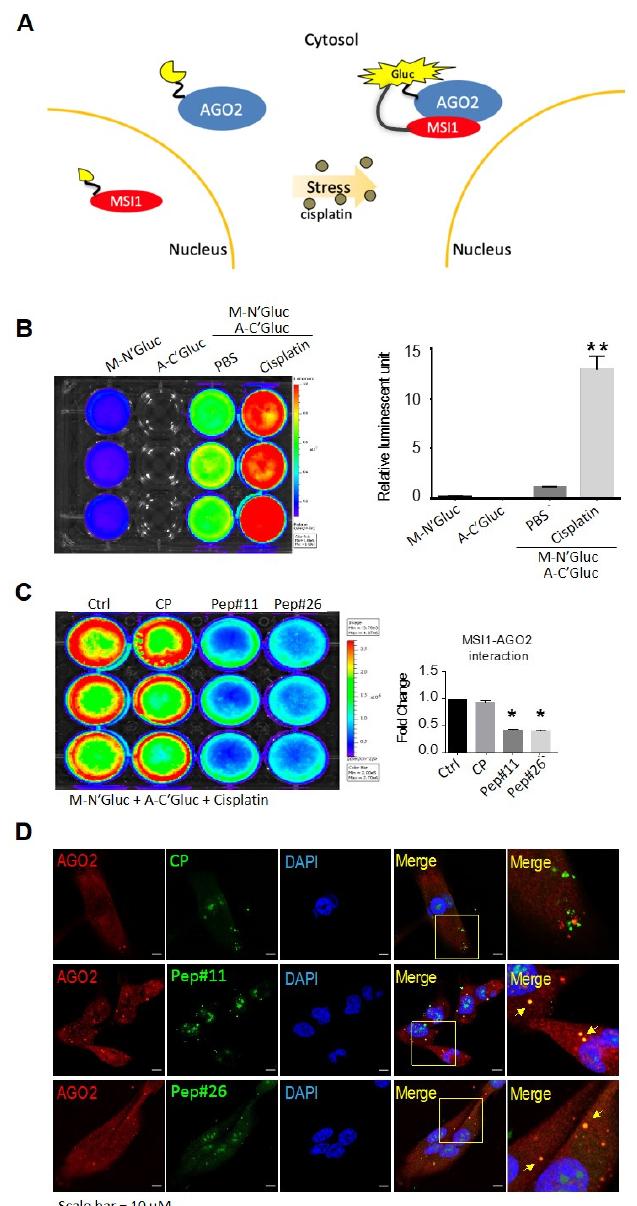
Figure 4. MSI1 C-terminal peptides Pep#11 and Pep#26 acted as decoys for MSI1/AGO2 interaction under cellular stress. ( A ) A schematic illustration that shows in vitro Gaussia luciferase reconsti- tution assay for the detection of MSI1 and AGO2 protein–protein interaction. ( B ) Gluc-mediated MSI1/AGO2 interaction was quantitatively determined using the split luciferase reconstitution assay as monitored by IVIS imaging system. In total, 30 µ M of cisplatin was used to induce cellular stress that led to MSI1/AGO2 interaction. M-N’Gluc (MSI1-N-terminal-Gluc); A-C’Gluc (AGO2-C-terminal- Gluc). **, p < 0.01. ( C ) Under the same cellular stress conditions induced by cisplatin, tat-conjugated CP (control peptide), Pep#11, and Pep#26 were employed, and luciferase signals were detected and quantitated by comparison to no treatment control (Ctrl) as normalized results were displayed as a bar chart. *, p < 0.05. ( D ) Cells treated with 10 µ M of 5 (cid:48) FAM-Pep#11, 5 (cid:48) FAM-Pep#26, or control peptide (5 (cid:48) FAM-CP) were analyzed under confocal microscopy for subcellular co-localizations (MSI1 peptides, green; AGO2, red). Scale bar = 10 µ M. In ( B , C ), The color spectrum bar represents the intensity of the luciferase activity (luciferase units): the red color indicates strong luciferase activity, meaning a strong protein-protein interaction of MSI1 and AGO2; whereas the blue color indicates weak luciferase activity, meaning a weak interaction between MSI1 and